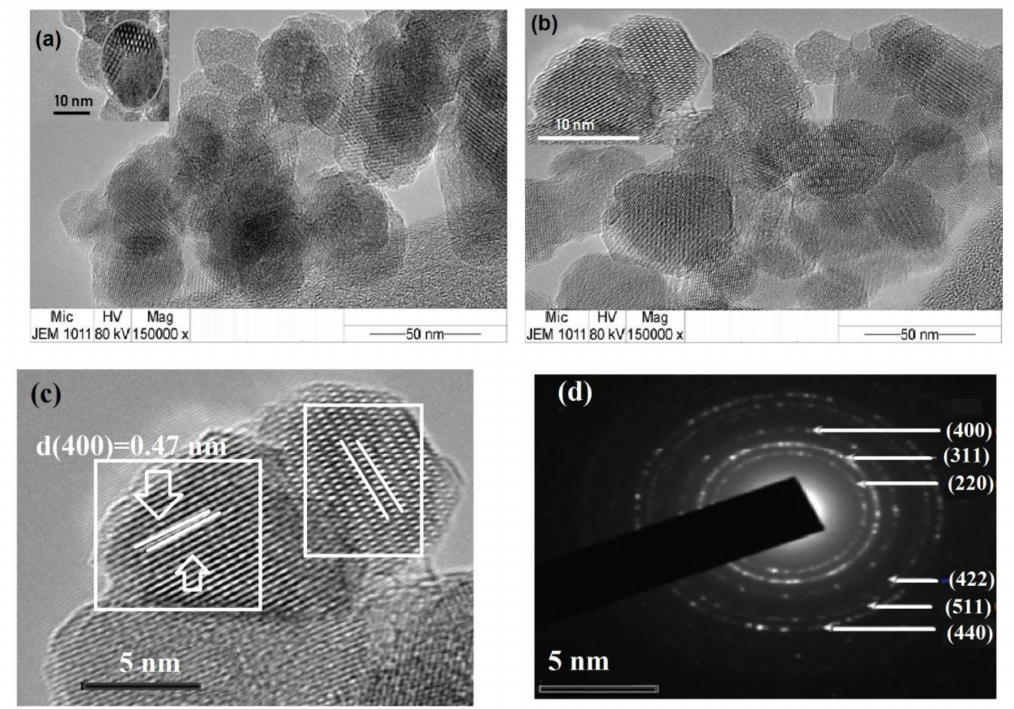
Figure 5. Transmission electron microscopy (TEM) micrographs of ( a ) HPHI-Fe 3 O 4 and ( b ) DCHI-Fe 3 O 4 NPs, ( c ) high resolution (HR)-TEM of DCHI-Fe 3 O 4 , and ( d ) selected area electron di ff raction (SAED) of DCHI-Fe 3 O 4